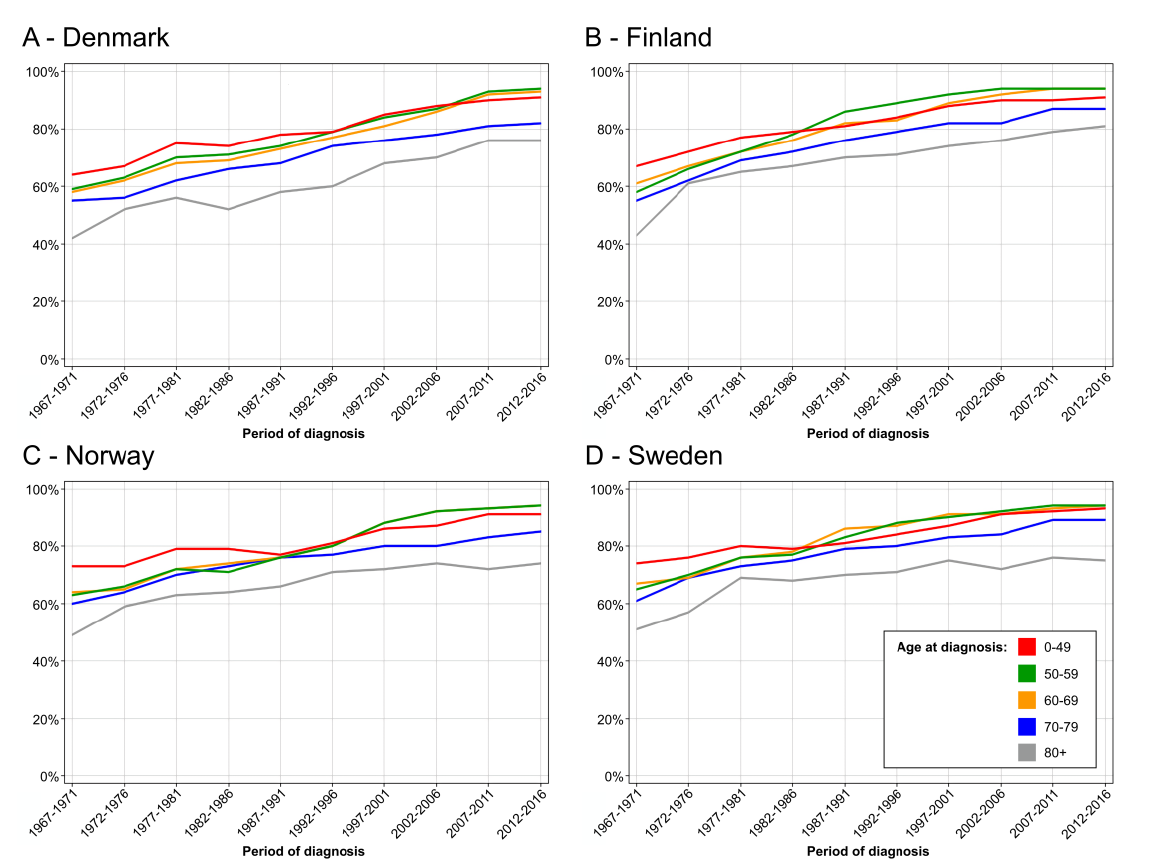
Figure 4. Age specific 5-year relative survival in female breast from 1967 – 71 to 2012 – 16, DK ( A ), FI ( B ), NO ( C ) and SE ( D ).